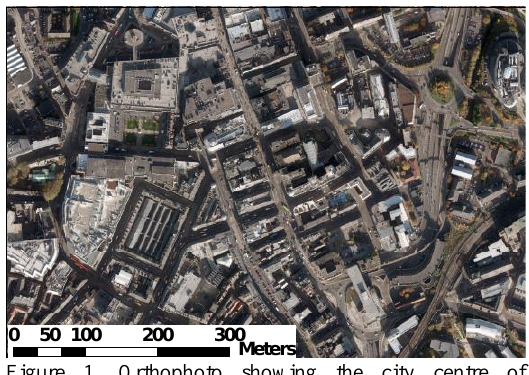
Figure 1. Orthophoto showing the city centre of Newcastle upon Tyne © UltraMap XP Image Copyright 2010, Ordnance Survey